Question: Judging by this figure, is the value going up or going down?
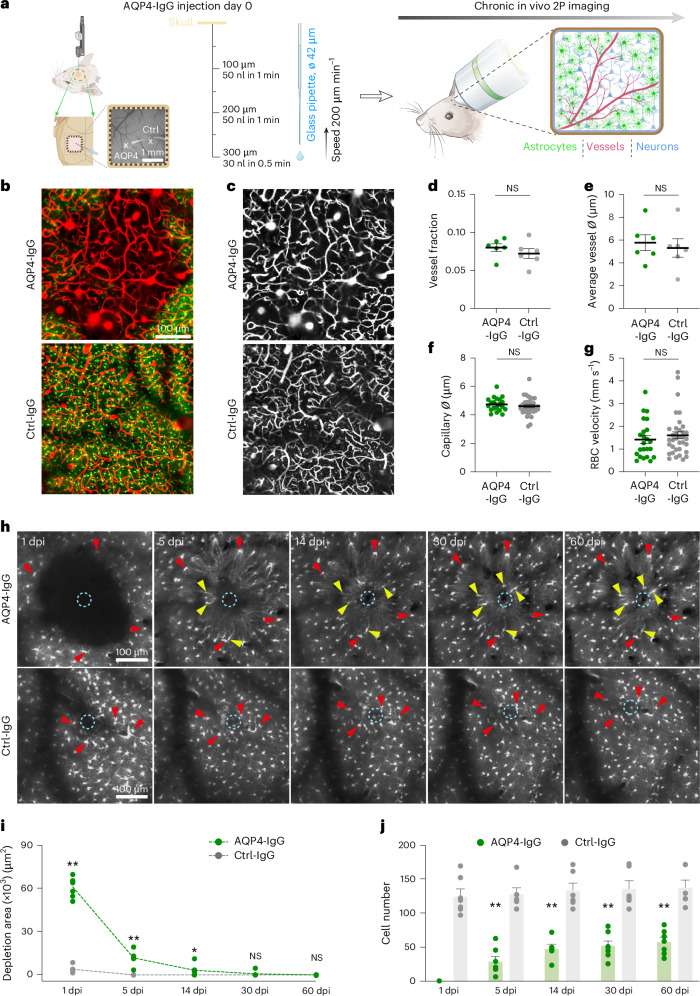
Answer: increasing